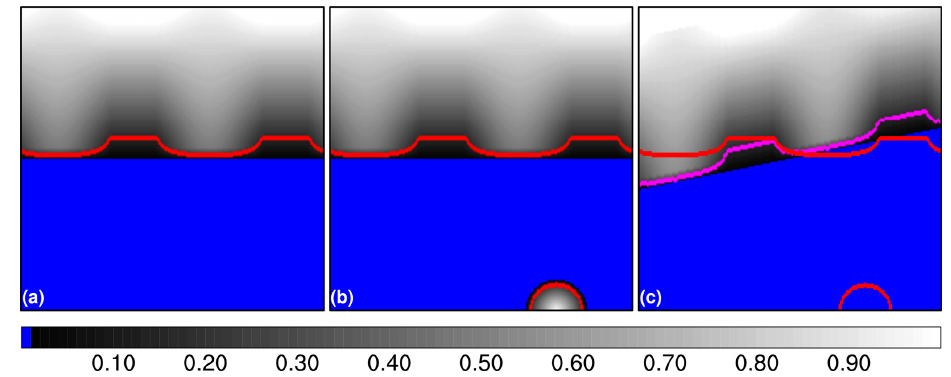
Figure 3. Sea ice concentrations representing (a) reference observations, (b) modified observations, and (c) model results. The ice edges in the observational and model product are drawn as red and magenta lines, respectively. (These lines are drawn with 3 times their actual thickness in order to accentuate the edges graphically.) Note that the ice edge from the modified observations has been added in (c) . Blue represents ice-free conditions, and the gray scale used for sea ice concentration is displayed by the label bar at the bottom.